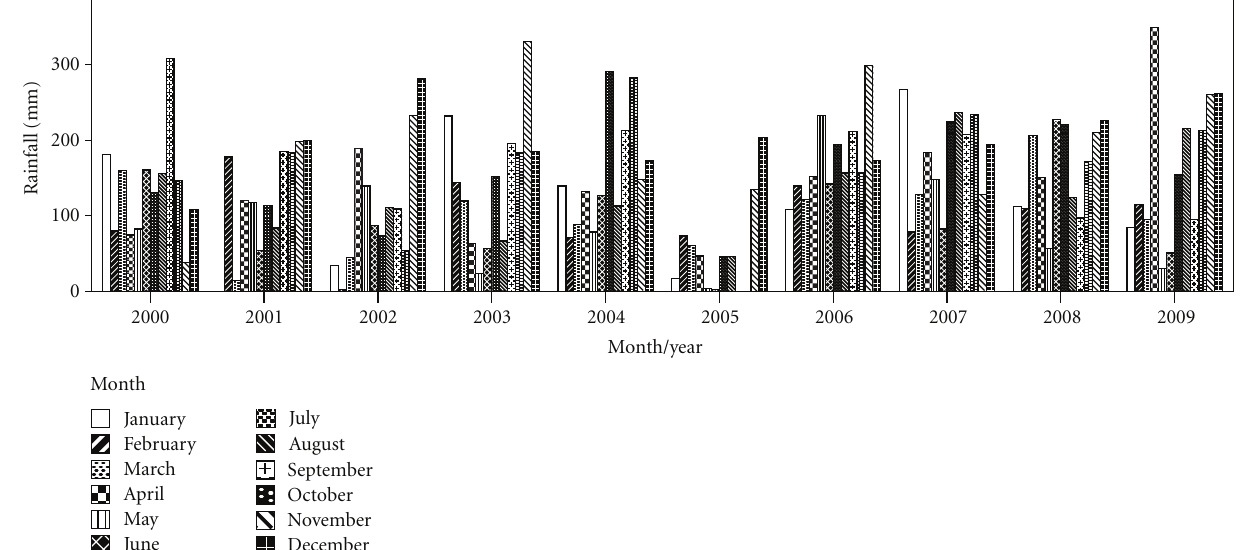
Figure 1: Monthly rainfall data for study area from 2000 to